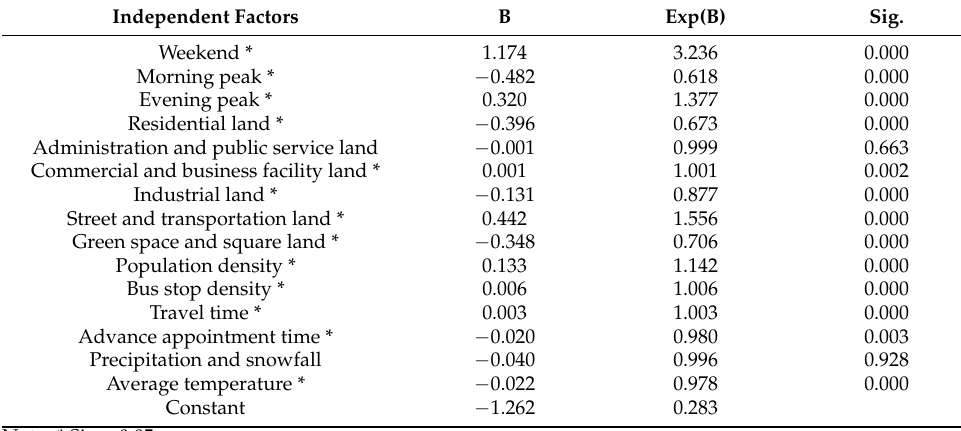
Table 3. Independent factor results of the Shizuishan